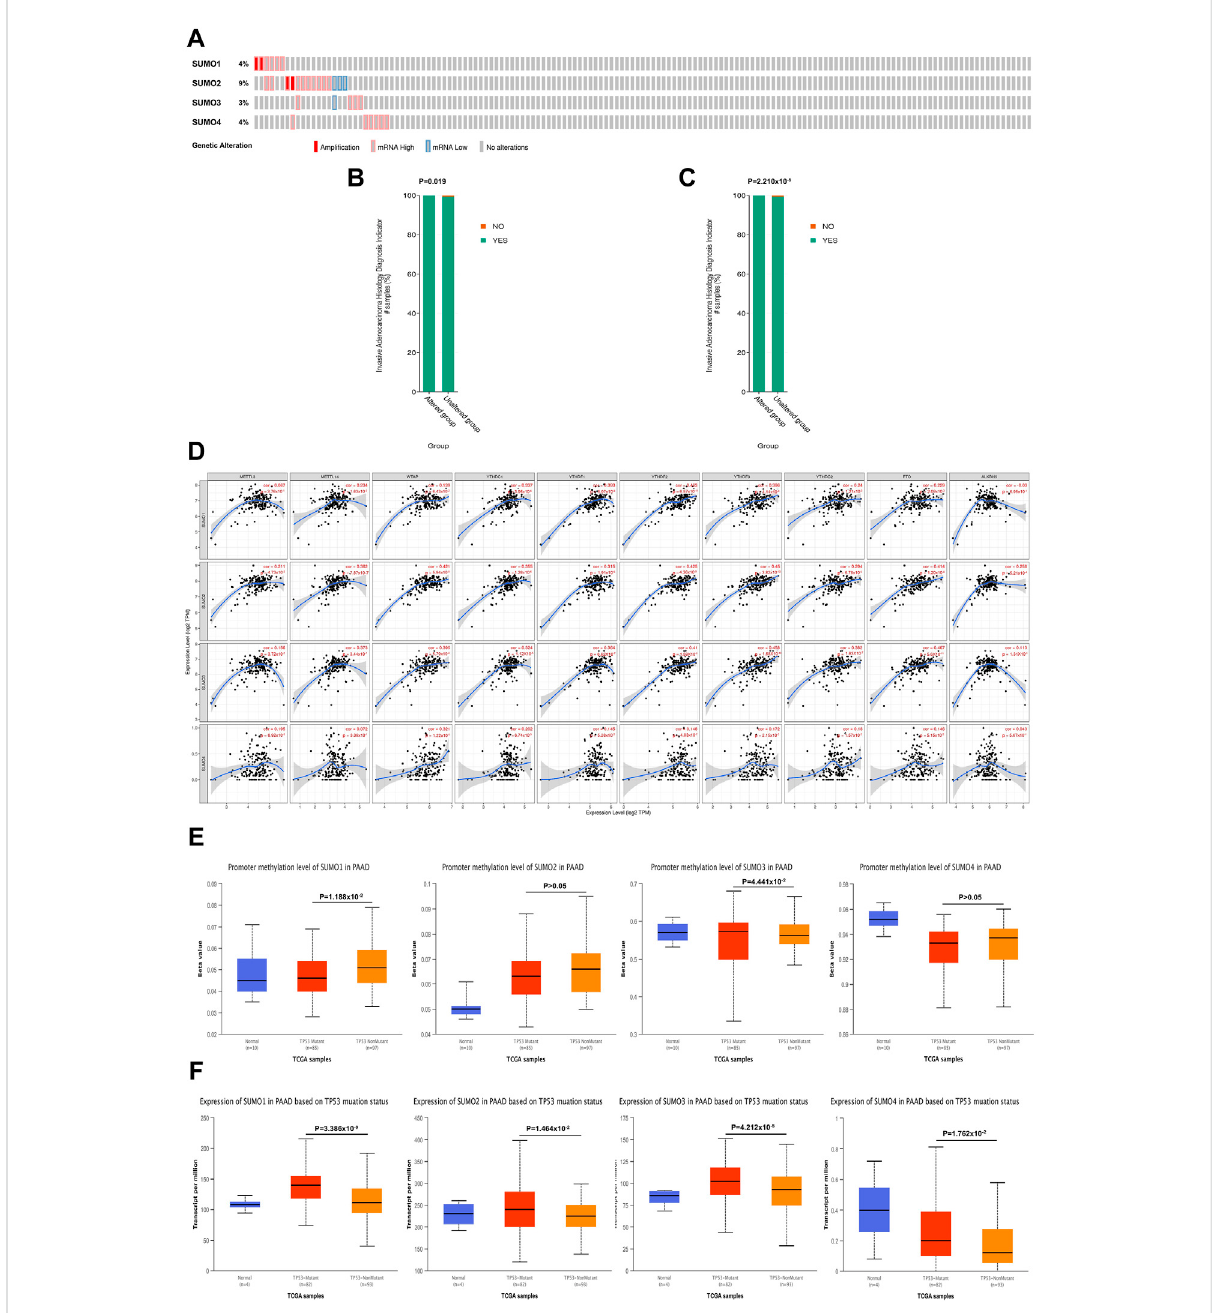
FIGURE 3 Genetic variation characteristics of SUMO family members in PAAD and relationship of their expression levels with m6A methylation regulators and TP53 mutation status. (A) Genetic variation characteristics of the SUMO family members in PAAD; (B,C) The ampli fi cation and mRNA High mutation of SUMO1/2 was signi fi cantly correlated with PAAD invasion of surrounding tissues; (D) SUMO family members were positively correlated with the expression levels of most M6A methylation regulators; (E) The promoter methylation level of SUMO1 in the TP53 mutant PAAD